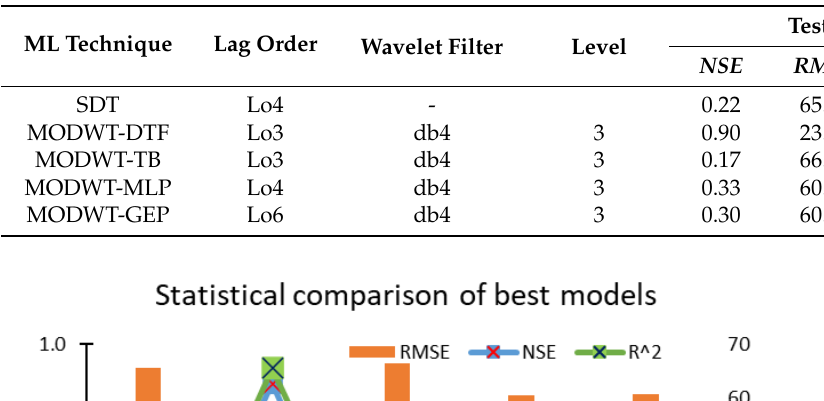
Table 5. Summary of best performing model comparison. Table 6. Summary of best performance models at low flows and high flows.